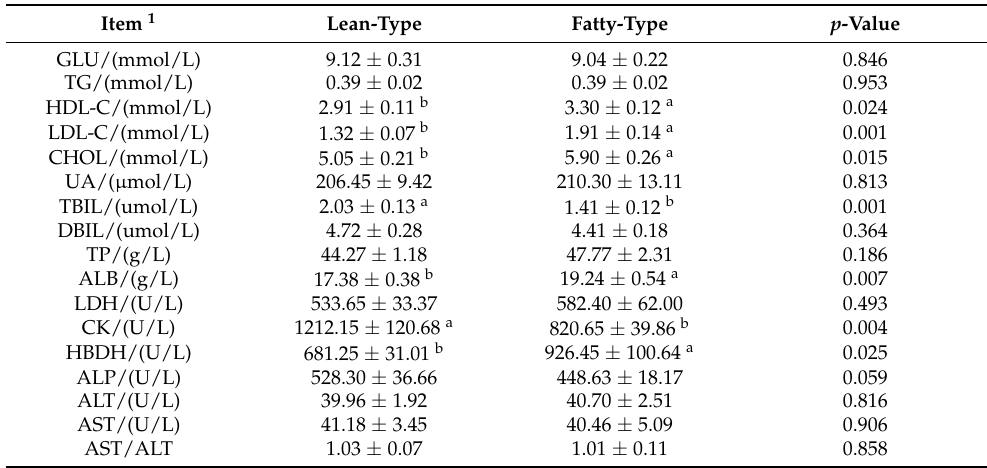
Table 3. Comparison of serum biochemical parameters between Lean-type ducks and Fatty-type ducks at 35 D.